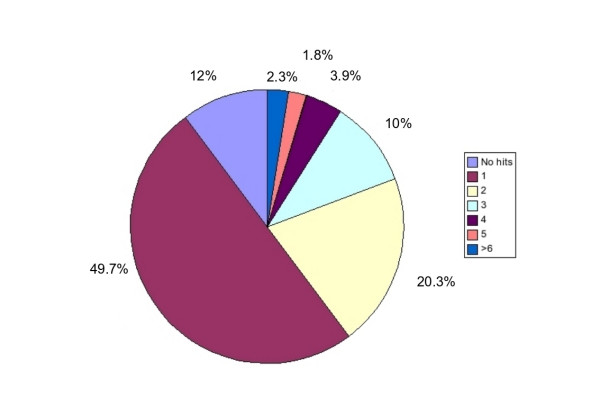
Distribution of fold recognition results. Distribution of the number of HOMSTRAD families predicted by FUGUE for a gene.